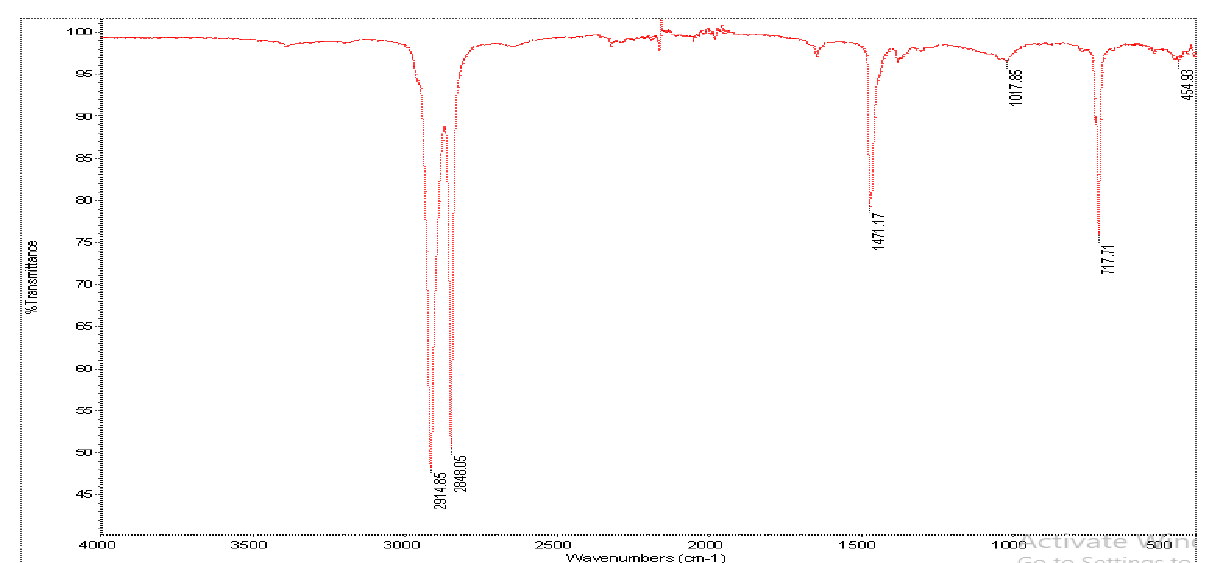
Figure 8. FTIR analysis of LLDPE blank sample at day zero (without thermal treatment).